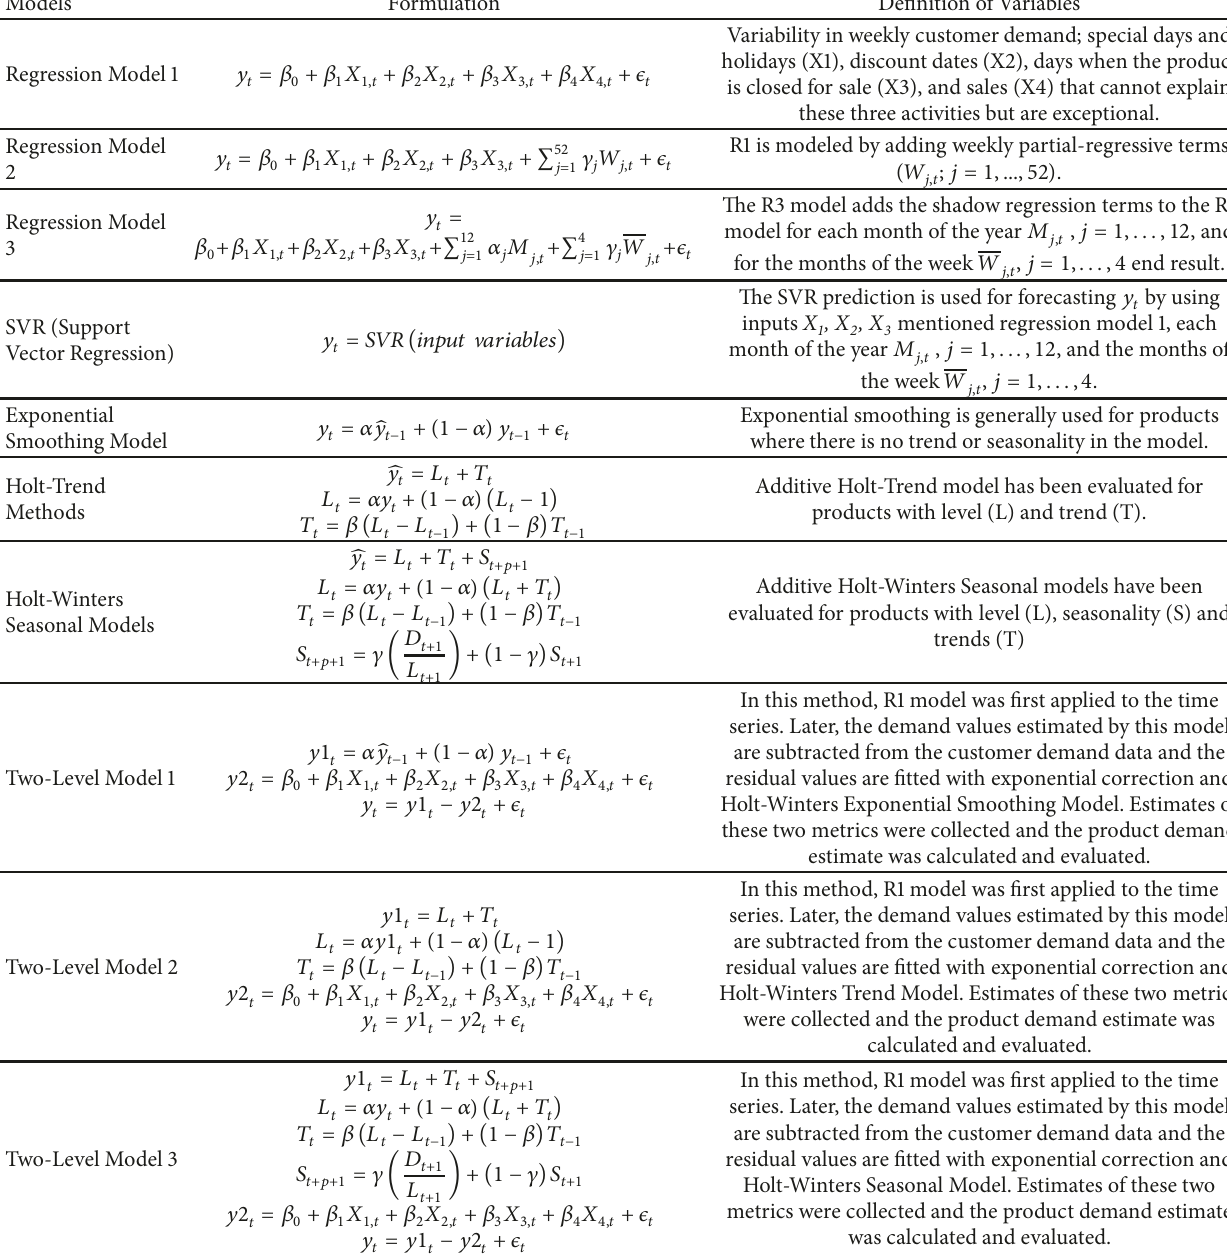
Table 1: Time series algorithms used in demand